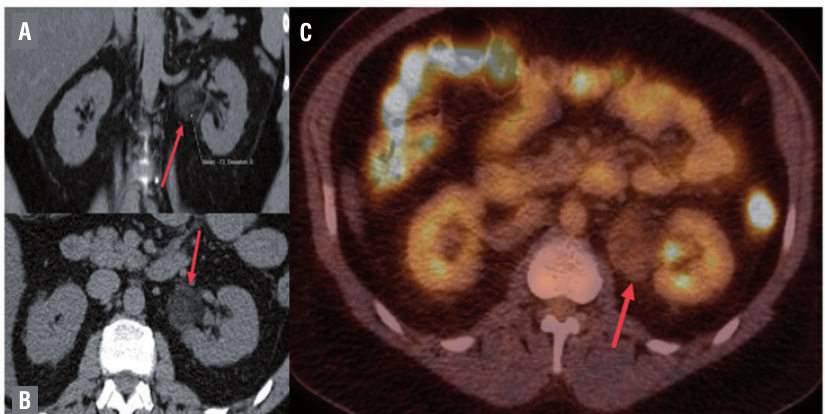
Figure 1 - CT Images. a) Coronal non-contrast CT demonstrating a peri-renal mass with heterogeneous attenuation. hounsfield units measured at -73 indicating fat in mass. b) Axial non-contrast CT again demonstrating left perirenal mass with heterogeneous attenuation arising from retroperitoneum. c) Axial PET/CT shows mild increased FDG uptake with suv (standardized uptake value) measurements of up to 2.8, which could represent malignancy or inflammatory